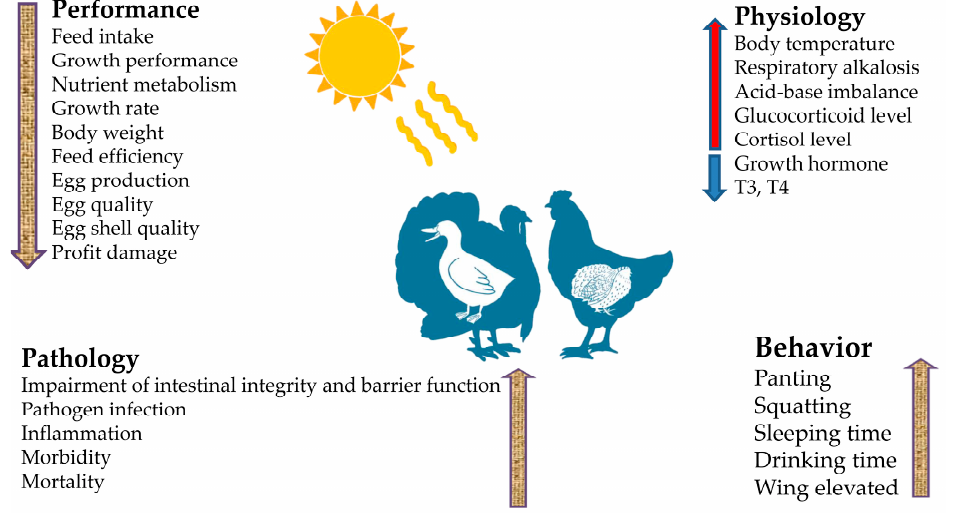
Figure 1. Effects of heat stress on growth, behavioral, and physiological traits.